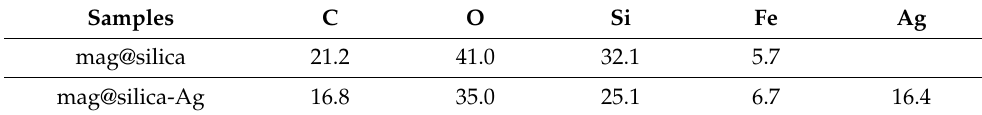
Table 3. The elemental ratio (Wt %) of mag@silica and mag@silica-Ag from XPS results.